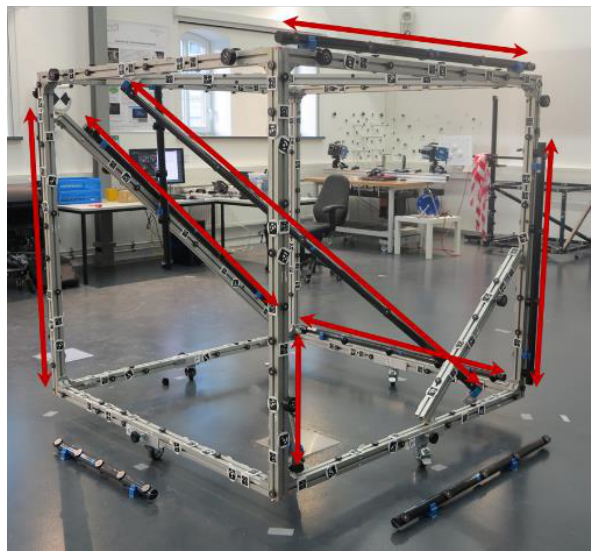
Figure 4. Testfield for accuracy evaluation according to German guideline VDI/VDE 2634.1